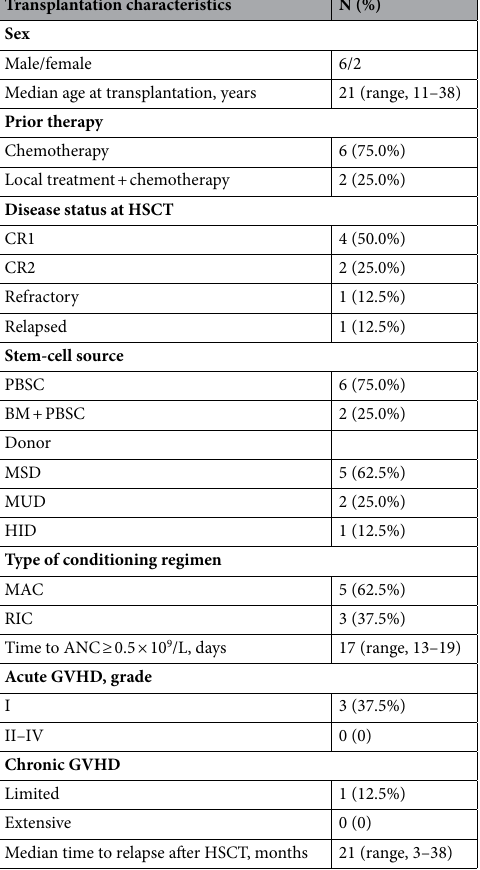
Table 3. Data of 8 cases with relapsed MS after transplantation. MS myeloid sarcoma, HSCT hematopoietic stem cell transplantation, CR1 first complete remission, CR2 second complete remission, PBSC peripheral blood stem cell, BM bone marrow, MSD matched sibling donor, MUD matched unrelated donor, HID haploidentical donor, MAC myeloablative conditioning, RIC reduced-intensity conditioning, ANC absolute neutrophil count, GVHD graft-versus-host